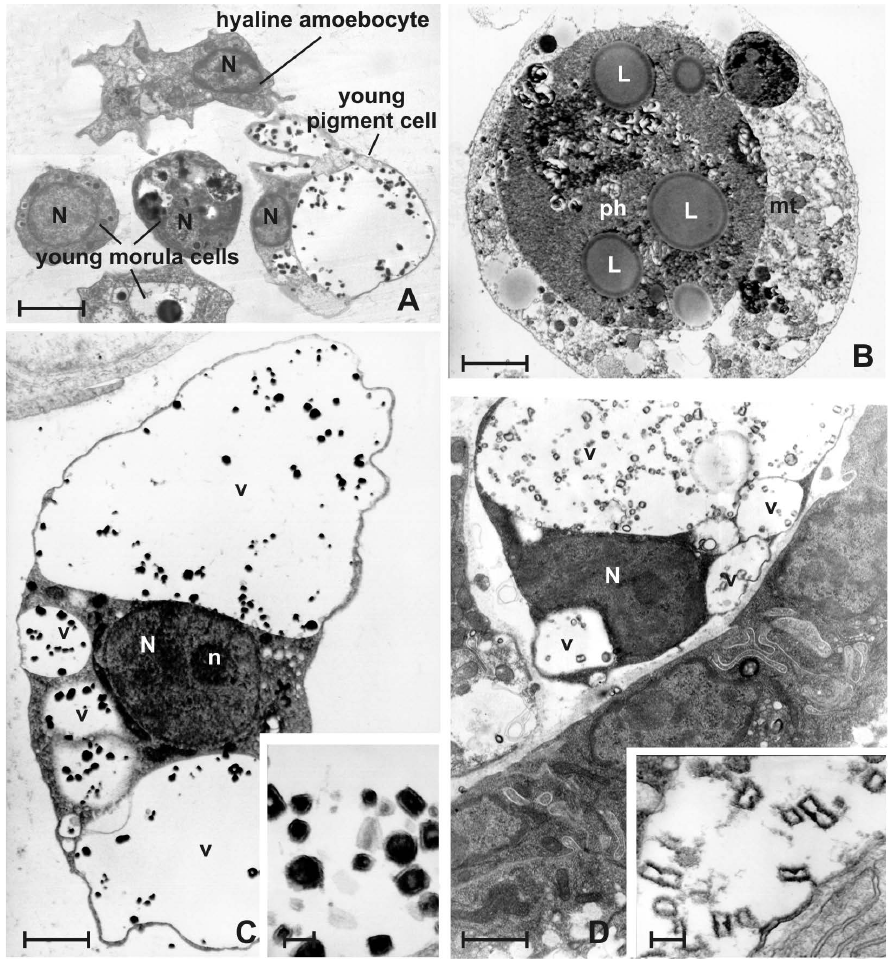
Figure 8. Oozoid: ( A ) young haemocyte types free in the lumen of the ampullae; ( B ) macrophage-like cell with a large phagosome containing digested cell debris and lipid droplets; ( C ) pigment cell with prismatic granules of ‘blue phenotype’ showing electron-dense layers ( inset ); and ( D ) nephrocyte showing the typical hourglass-shaped granules of uric acid in the large vacuoles. L —lipid droplet, N —nucleus, n —nucleolus, ph —phagosome, and v —vacuole. Bar length: 4 µ m in ( A ); 3 µ m in ( B ); 1.5 µ m in ( C ); 1.6 µ m in ( D ); 0.2 µ m in inset of ( C ); and 0.3 µ m in inset of ( D